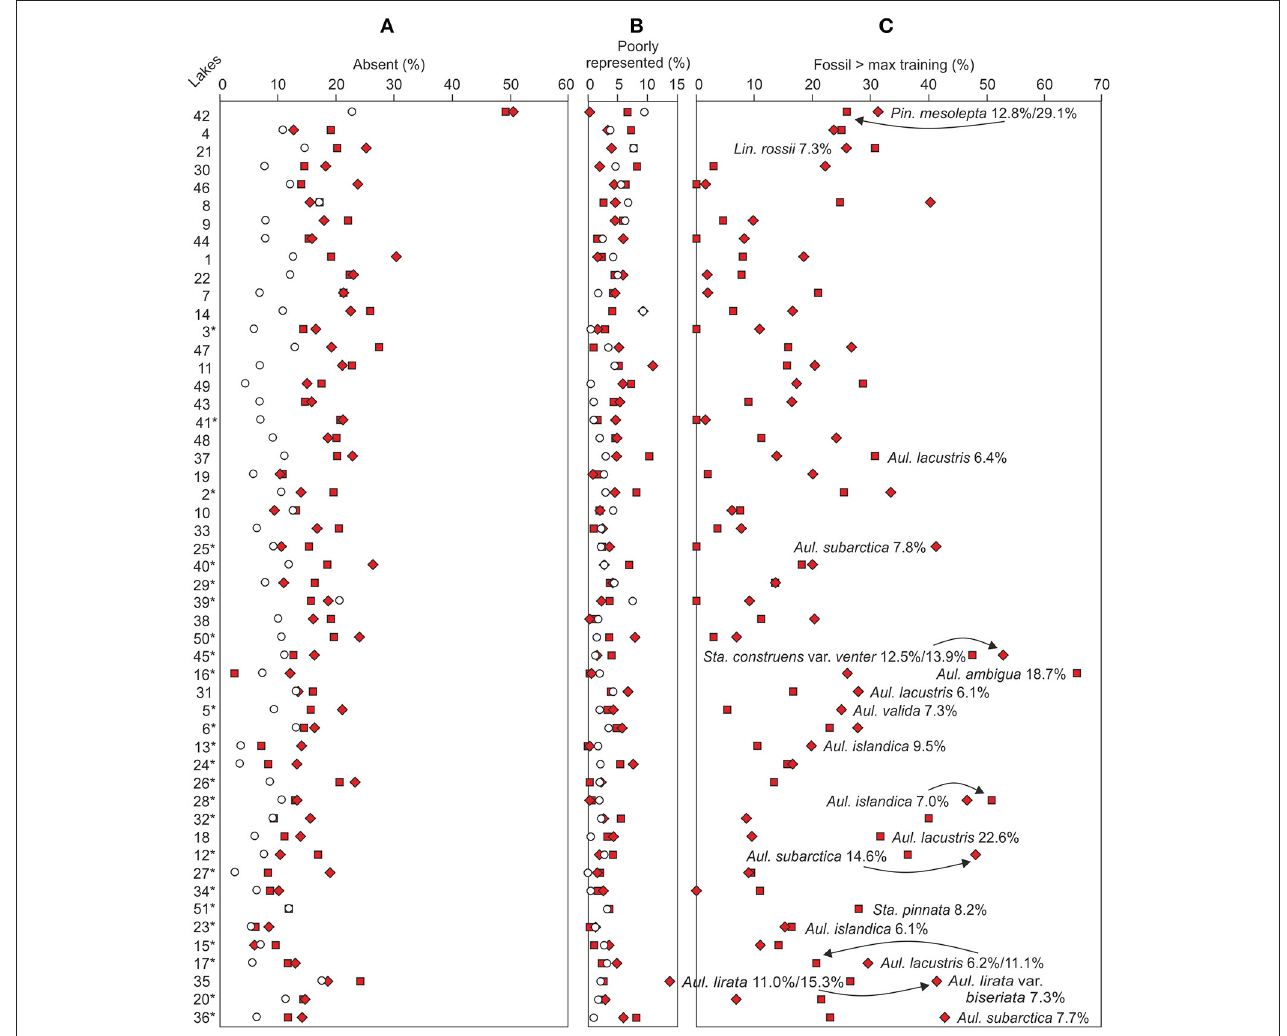
FIGURE 5 | Similarity between the top (empty circles) and bottom (filled squares lower bottom sample and diamonds upper bottom sample) samples based on the percentages of fossil taxa (A) absent from or (B) poorly represented in the modern training set. (C) Taxa with higher fossil abundances than the training set maximum abundance. Taxa with fossil abundances over 5% higher than the training set maximum values are marked in the figure. The sampling sites (see Table 1 for names and locations) are organized according to increasing bottom sample total phosphorus reconstructions. The Iisalmi Route sampling sites are marked with an asterisk.